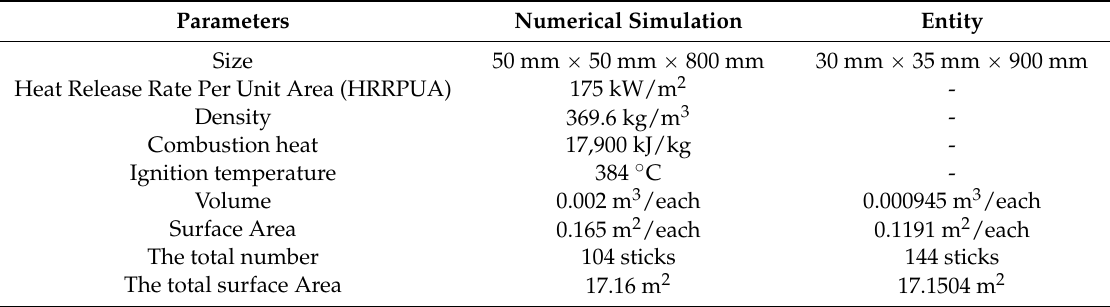
Figure 4. ( A ) The woodpile model (standard model for Fire Extinguisher Approval testing); and ( B ) an isometric view of the wood model. Table 3. Scenario description in the different simulation